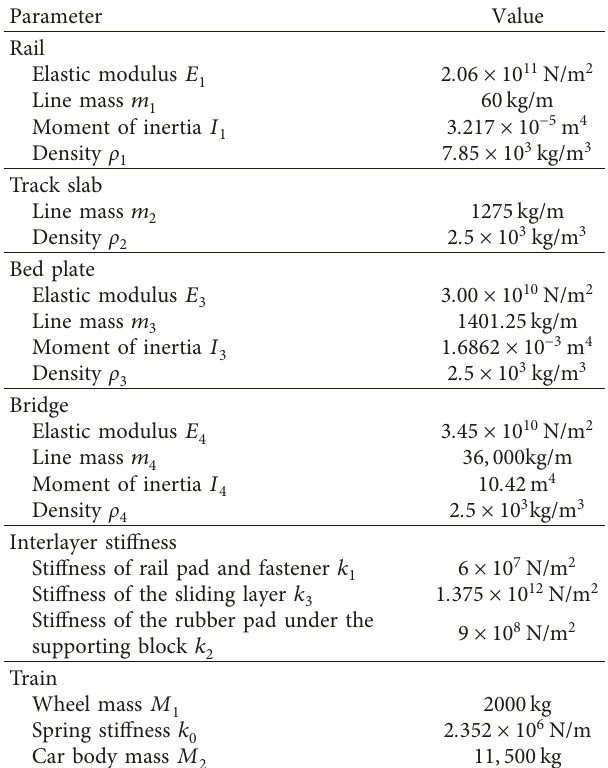
Table 3: Material properties and geometric parameters of the beam-rail